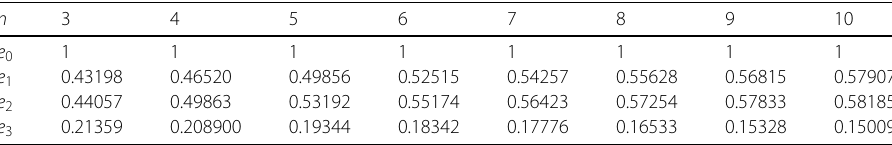
Table 5 Eigenvalues of of hyperbolic (i.e., μ (cid:2) +1 = cosh(2 π /5 × 2 (cid:2) +1 )) subdivision matrix with valence